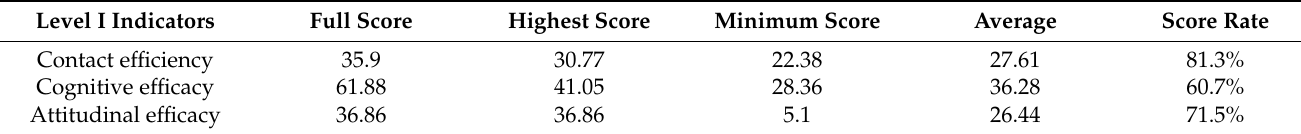
Table 8. Score rate of primary